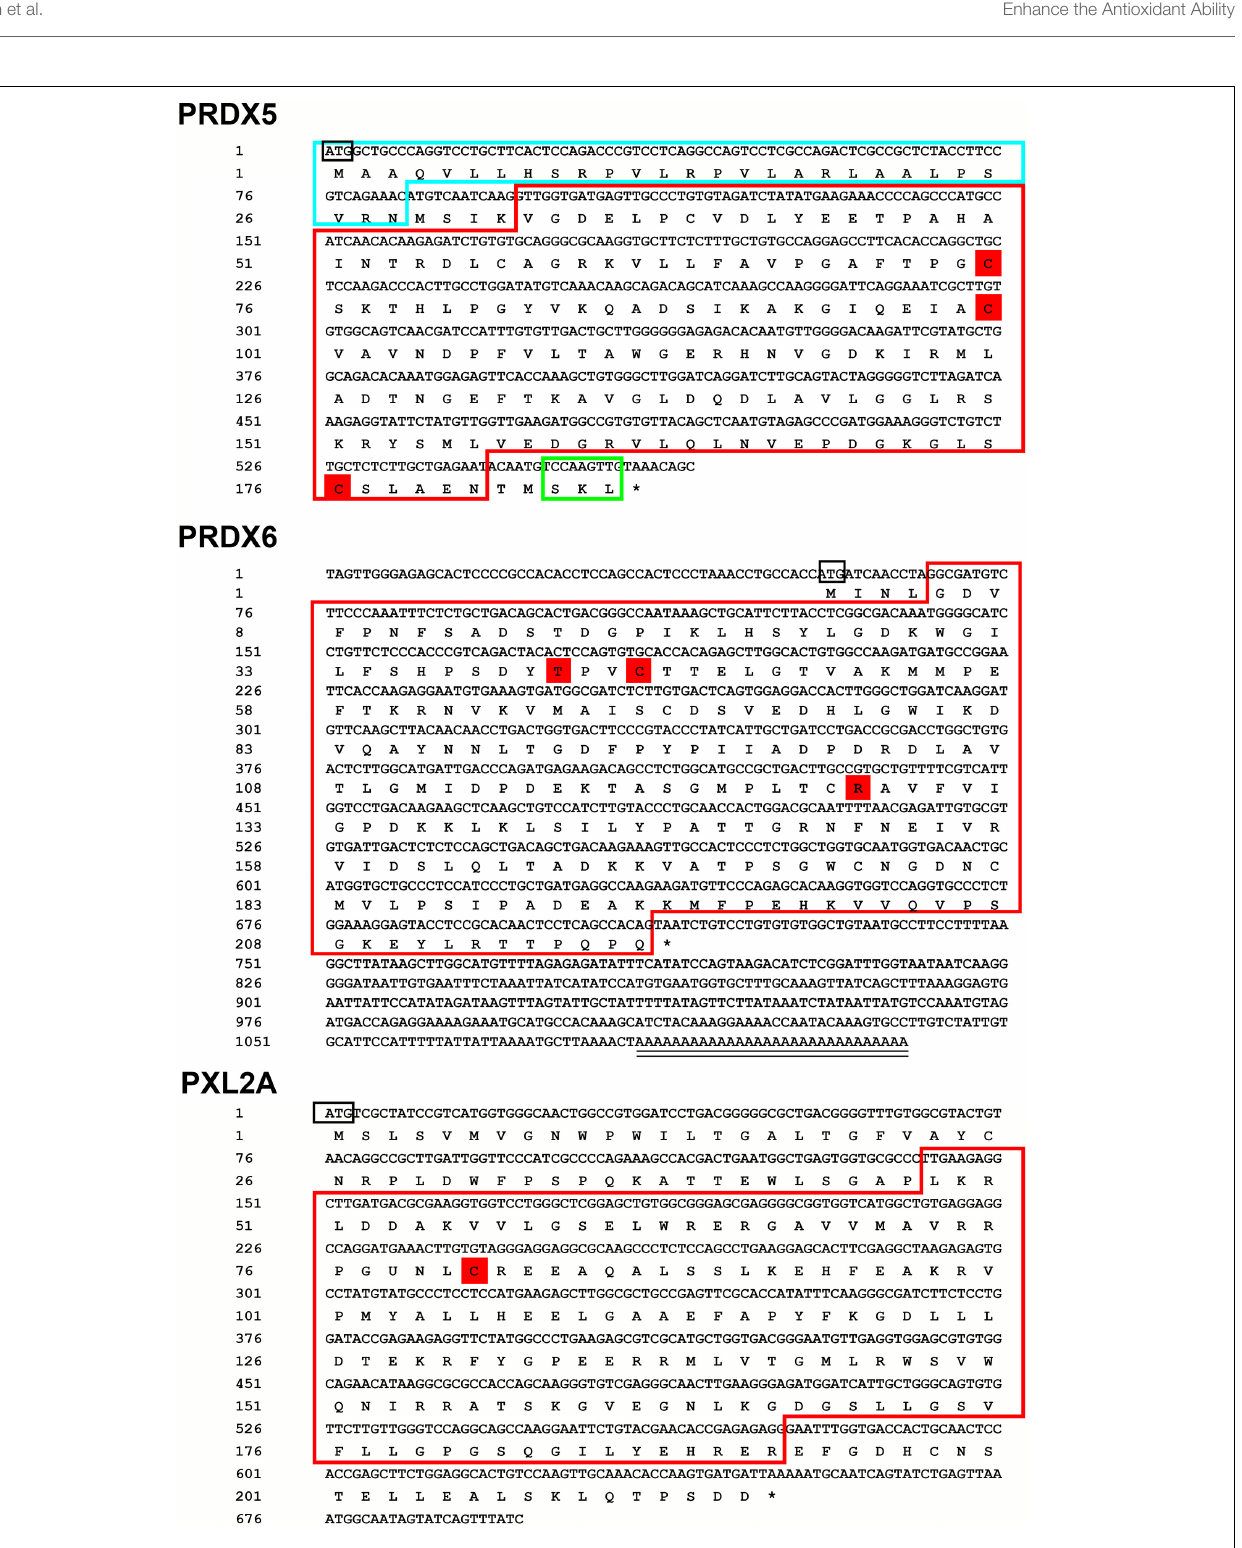
Frontiers in Marine Science |